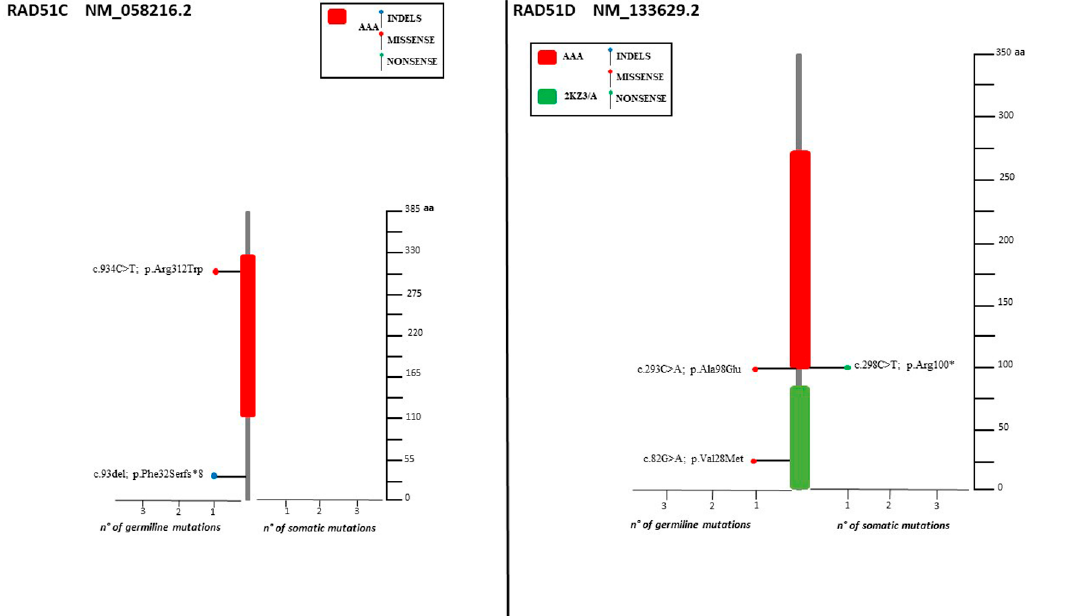
Figure 4. Lolliplots showing germline and somatic variant spectrum (both pathogenic and VUS) throughout the whole protein sequences of RAD51C and RAD51D . The vertical black scale bar represents the length (amino acids) of the protein sequence. The horizontal bar represents the number of patients affected by the specific mutation. Each lolliplot represents a variant identified in this study. The blue lolliplot identifies a shorts indels mutation (deletion or duplication). The red lolliplot indicate a missense variant, while the green ones a nonsense